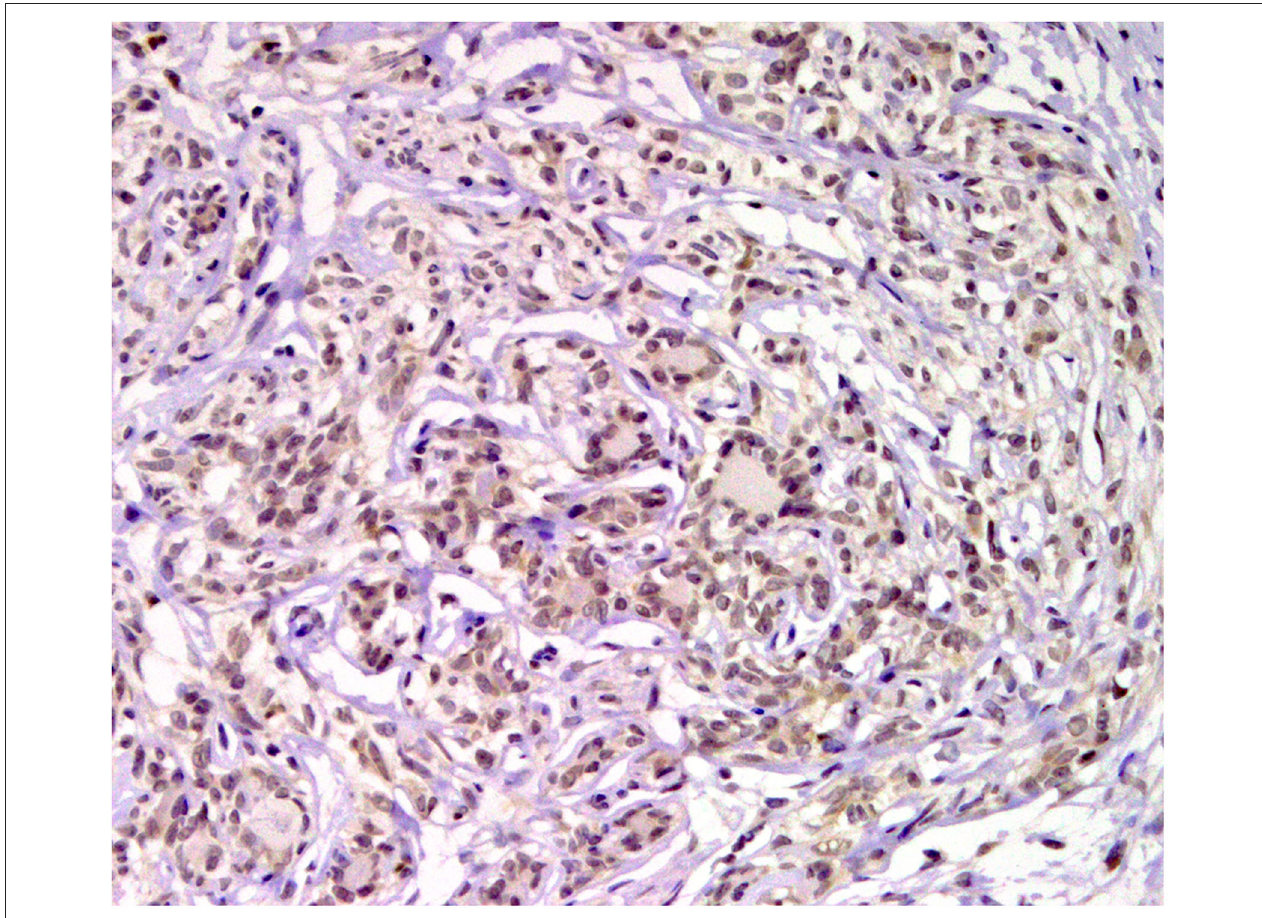
FIGURE 8 | Tubular carcinoma, mammary gland, dog. Immunohistochemical nuclear staining of progesterone receptor (PR). Neoplastic cells are positive.